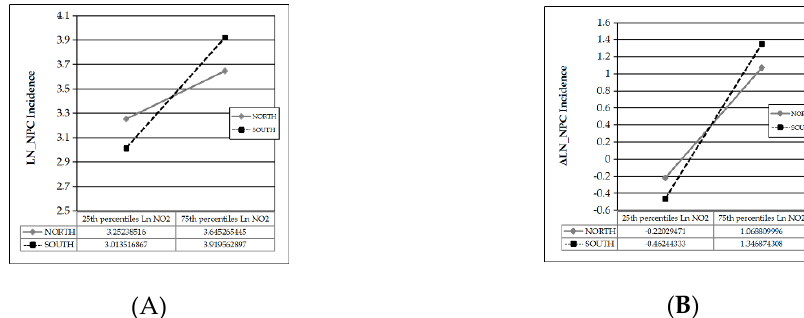
Table 3. Cumulative health e ff ect of air pollution on NPC incidence and its growth